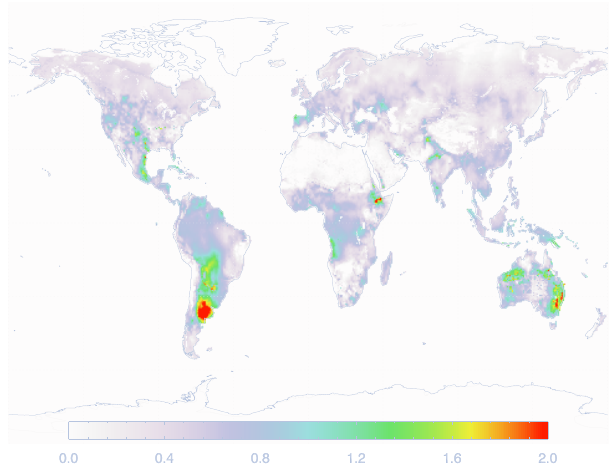
Figure 5. Geographic distribution of the increase in NNF due to rising CO 2 (gNm − 2 yr − 1 ) .